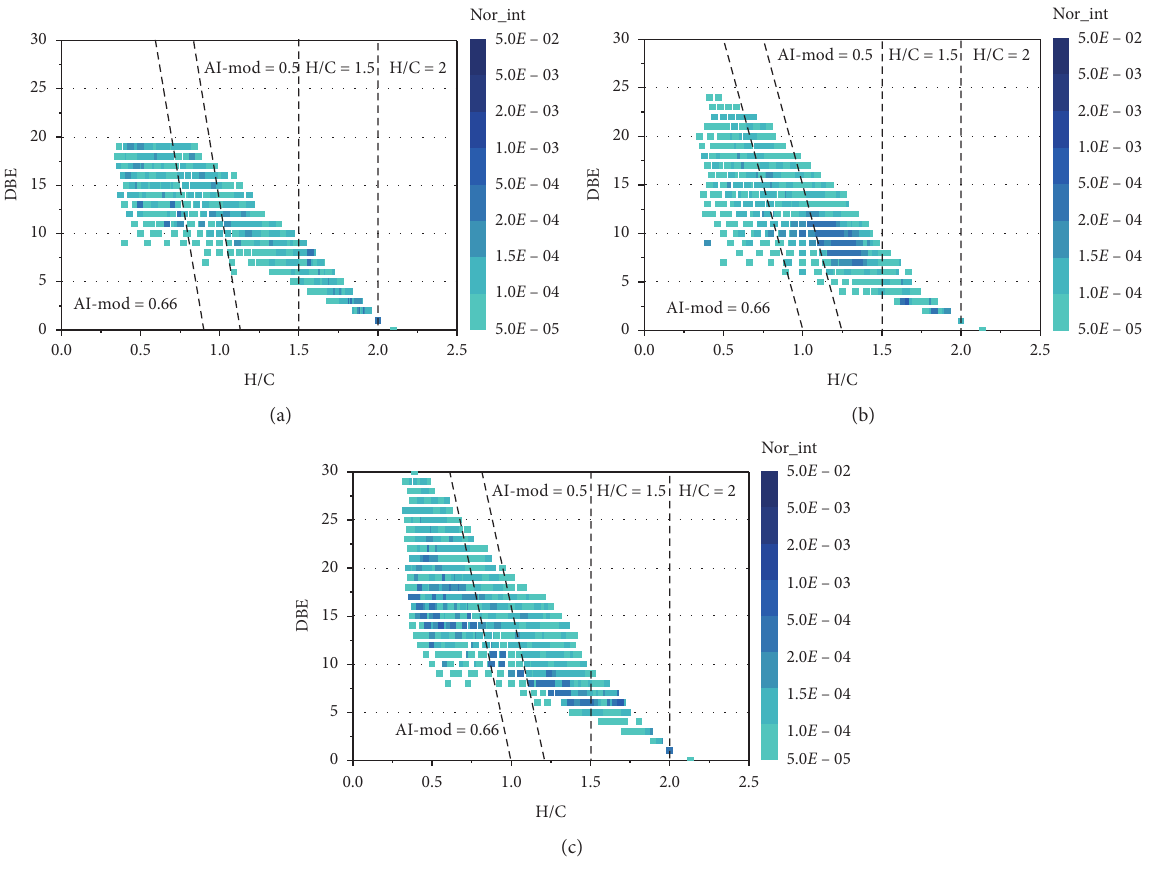
Figure 3: Respective DBE-H/C diagrams from (a) humic acids from Jiufeng forest soil, (b) humic acids from Suwannee River, and (c) humic acids from leonardite. Nor_int is the normalization of the intensity of each